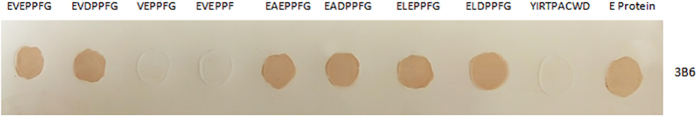
Identification of the E protein epitope.Peptide fragments were probed for reactivity with the 3B6 mAb by dot-blot assay. YIRTPACWD and full-length DTMUV E protein were used as negative and positive controls, respectively.